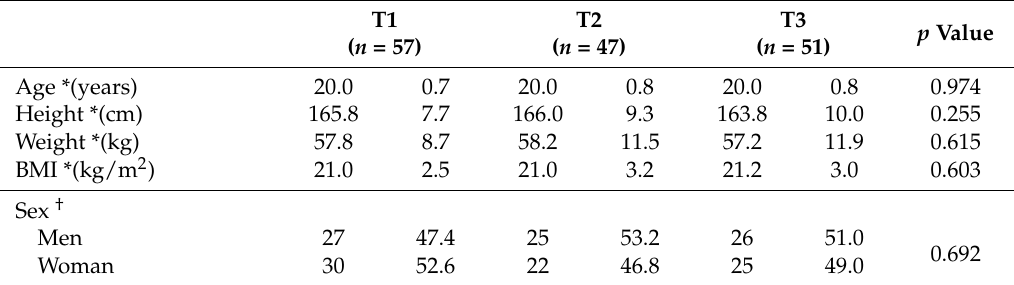
Table 1. Association between the Food Guide score and demographic